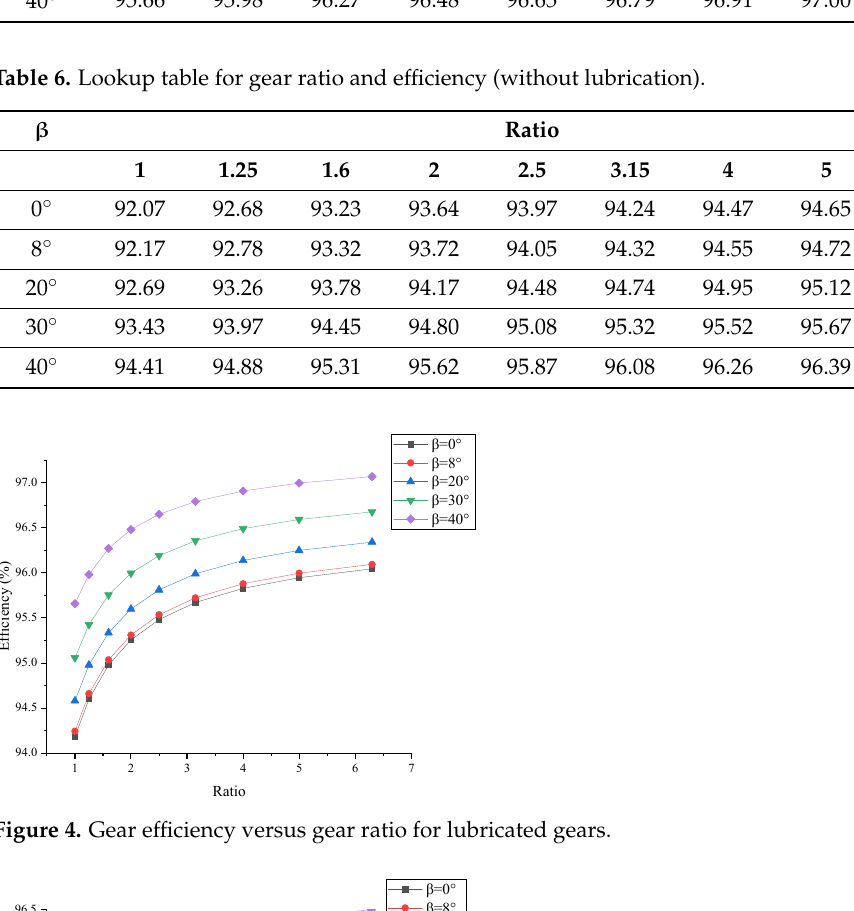
Table 5. Lookup table for gear ratio and efficiency (with lubrication).